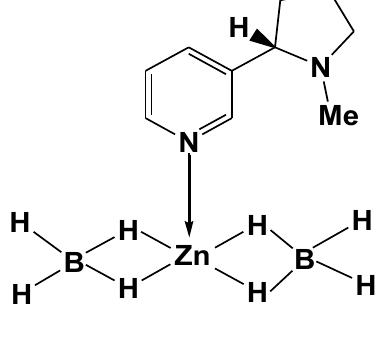
Figure 1. (Nicotine)(tetrahydroborate)zinc complex.